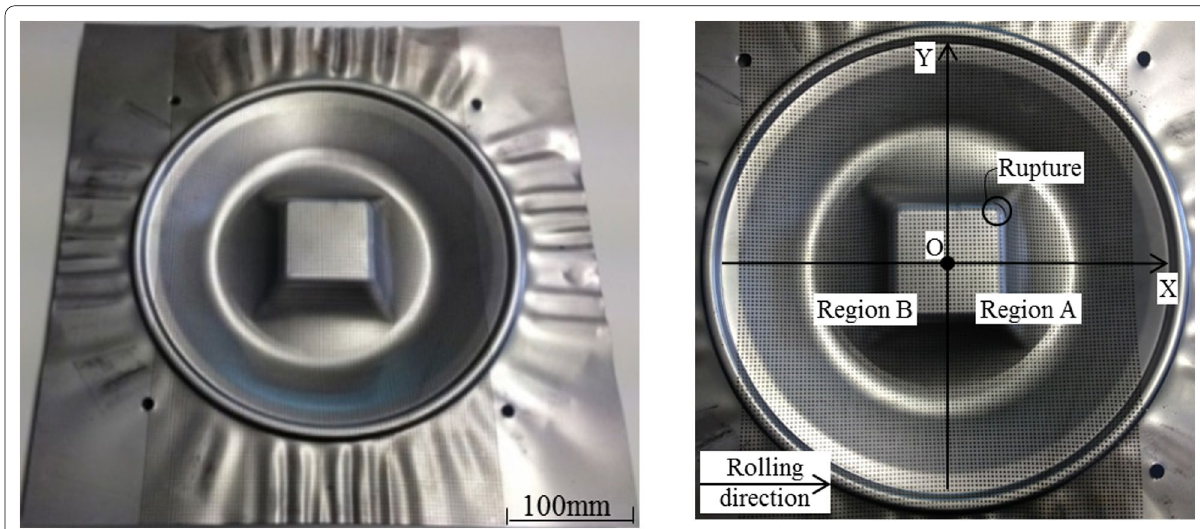
Figure 10 a Forming a sheet metal using the hybrid forming; b Coordinates used for the foring analysis